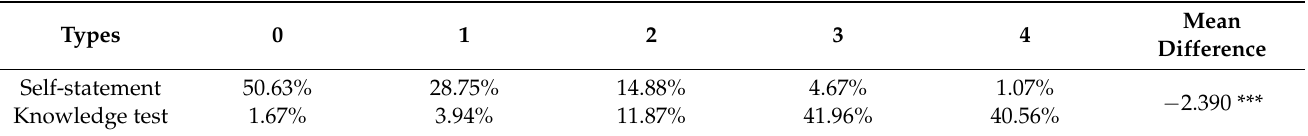
Table 3. Respondents’ mastery of animal welfare knowledge.